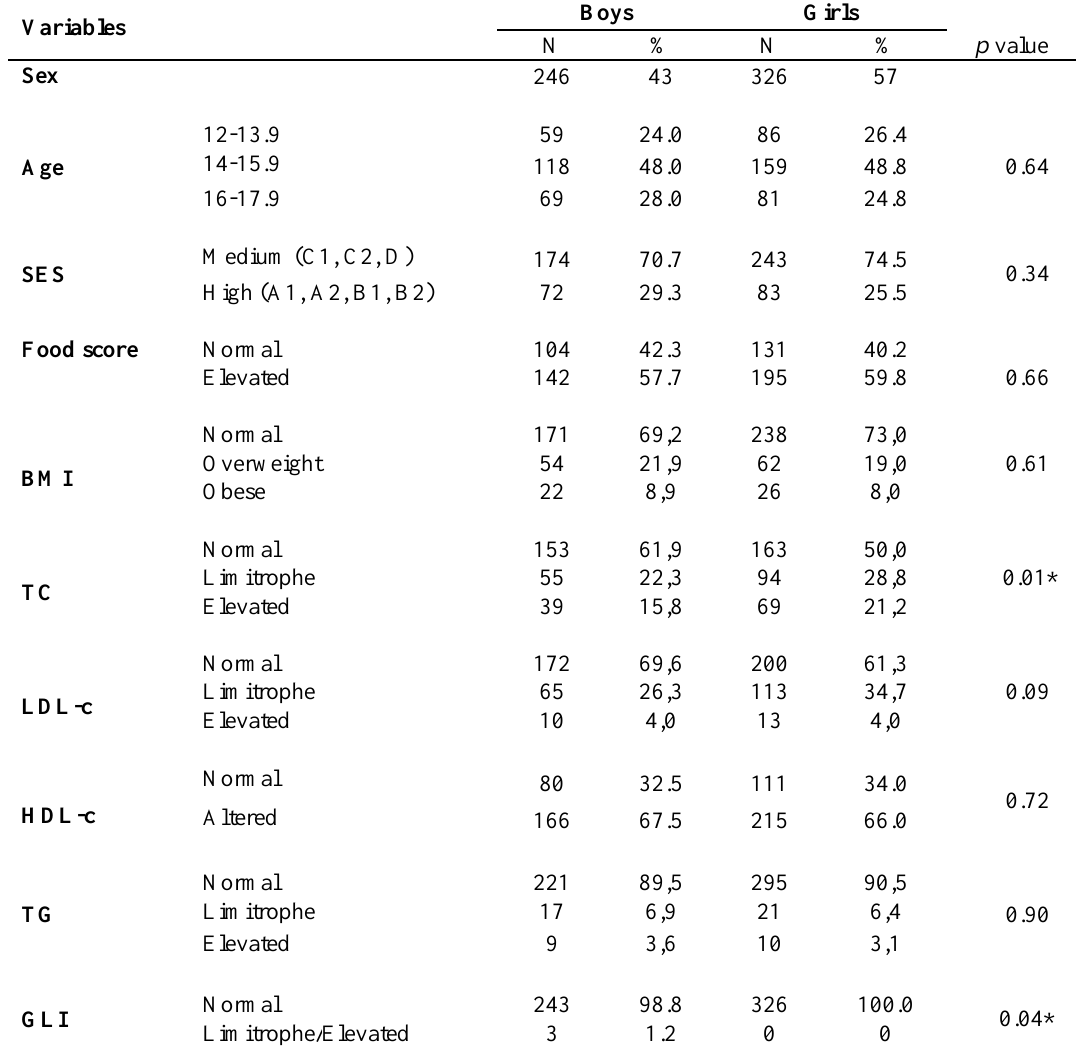
Sex differences calculated by Fisher's Exact Test (two classifications) or Chi-Square Test (three or more classifications). *Significantly ( p <.05) for Fisher's Exact